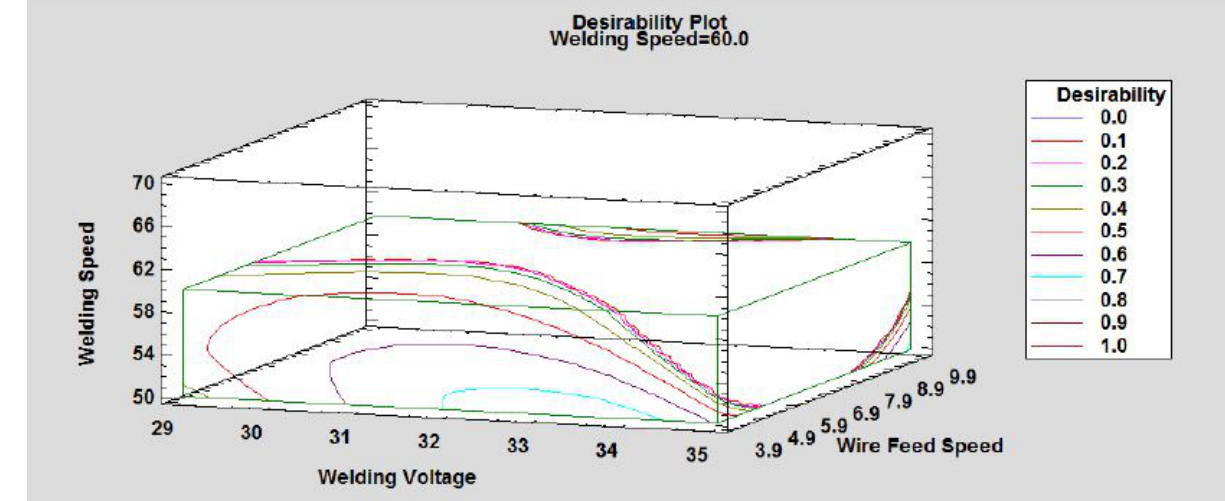
Figure 7. Optimum factors setting at the optimum desirability